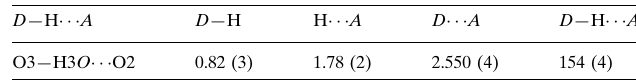
Hydrogen-bond geometry (A˚ , (cid:2)